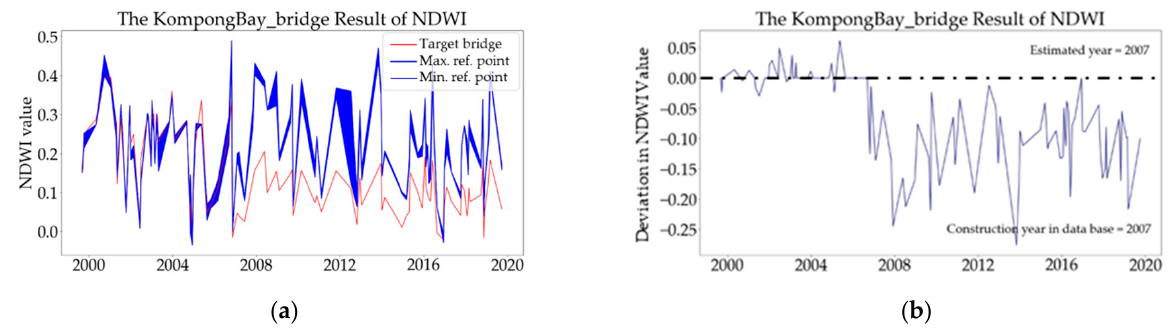
Figure 16. ( a ) NDWI results for Kom Pong Bay bridge, which indicate the year of construction to be 2007 based on deviation from the reference points; ( b ) re-visualization of ( a ) showing the NDWI difference; the change in 2007 is clear.